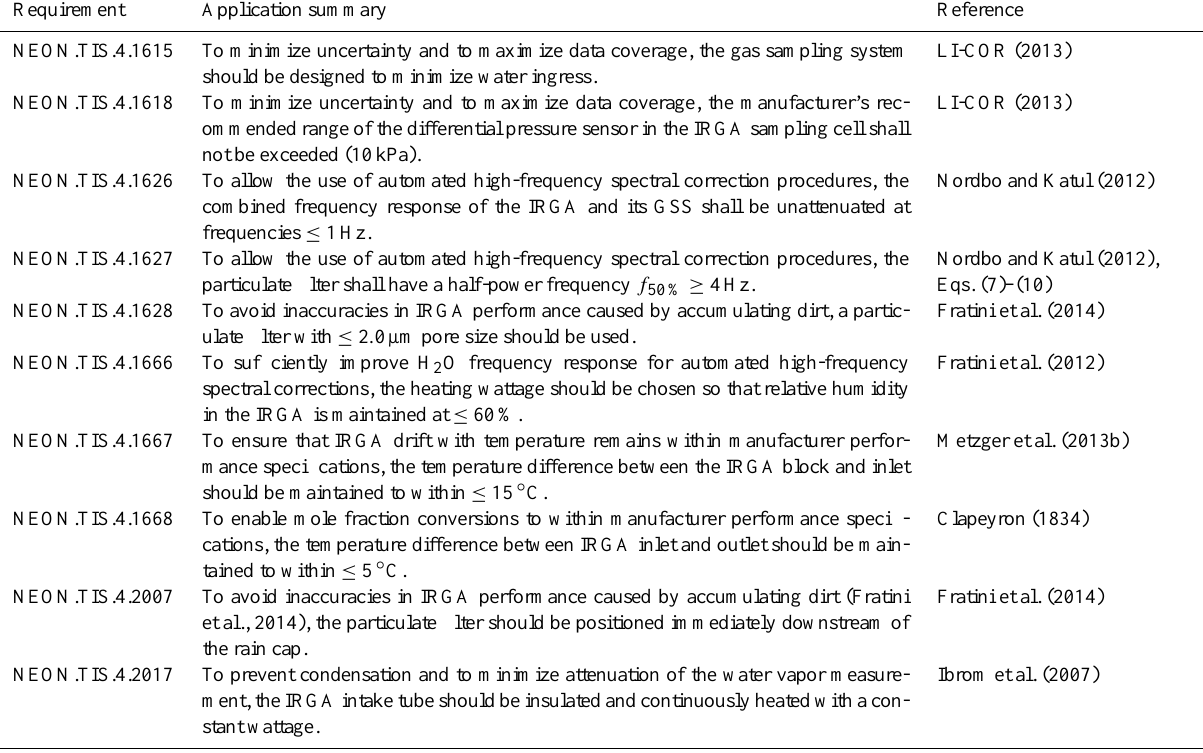
Table 1. Summary of tested NEON requirements and applicable